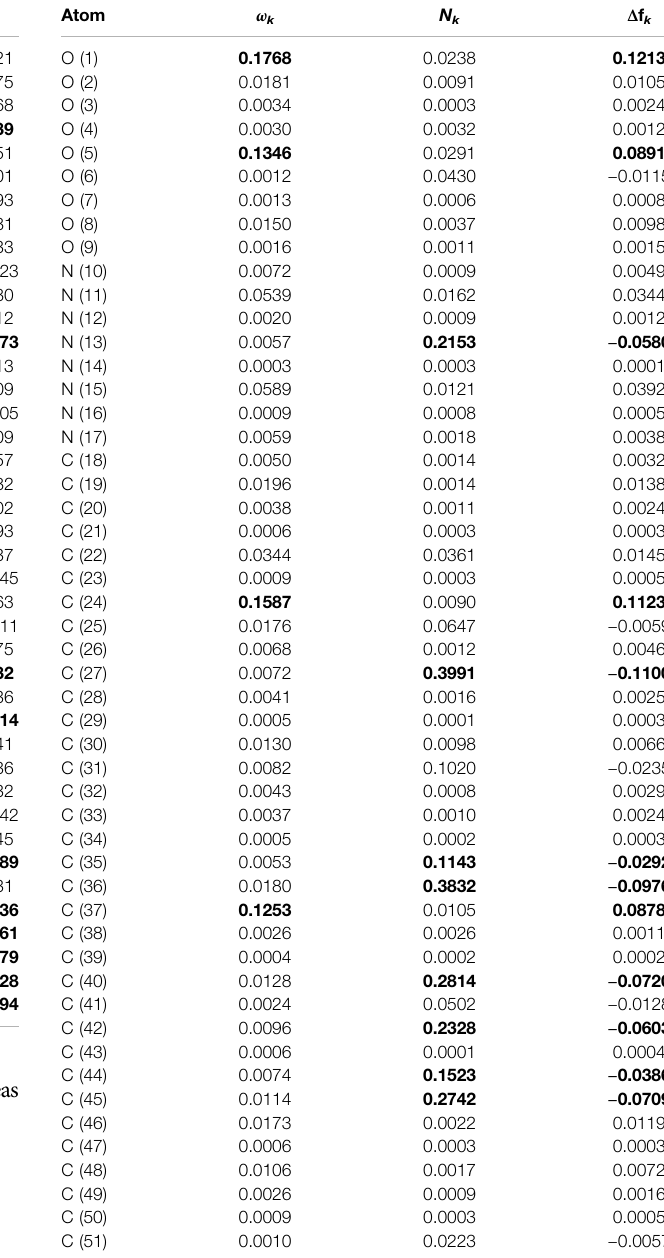
TABLE 11 | Comparison of several reactivity descriptors: condensed electrophilicity ω k , condensed nucleophilicity N k and condensed dual descriptor Δ f k , over the atoms of Pashinintide A. H atoms are not shown.